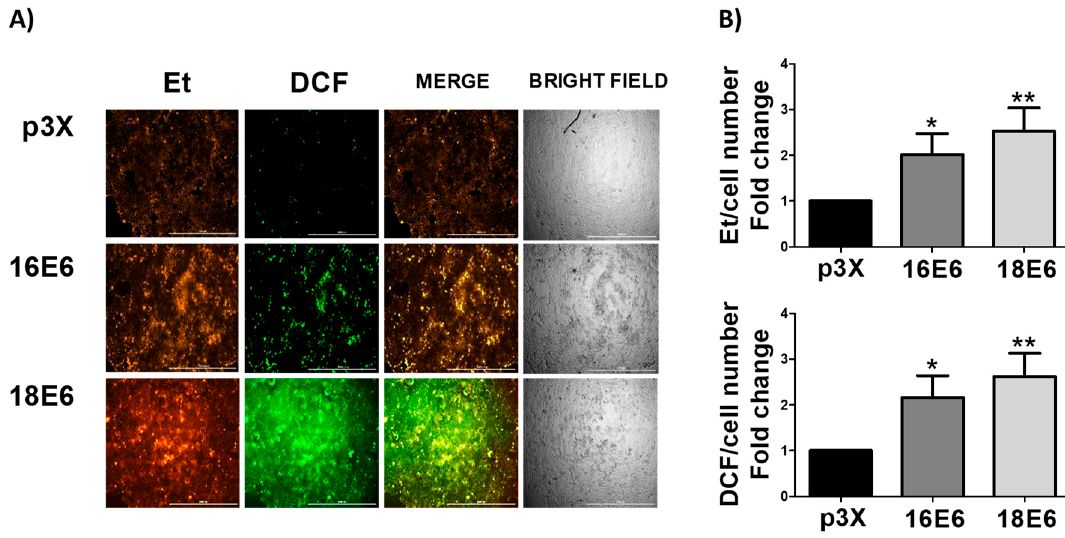
Figure 6. E6 oncoproteins from HPV16 and HPV18 increase reactive oxygen species (ROS) in FaDu cells. ( A ) Representative images and ( B ) quantitative data of ROS generated by E6 proteins from HPV types 16 and 18. Quantitative data were obtained from cells expressing E6 from each viral type, comparing with p3X-transfected cells as control. The mean intensity of ethidium (Et) and dichlorofluorescein (DCF) fluorescence were measured using Gen5 TM 3.0 software for image acquisition and quantification. The fluorescence intensity is expressed as the mean ± SD. Tukey’s test * p < 0.05, ** p < 0.005 and *** p < 0.0005 vs. control (p3X), n =